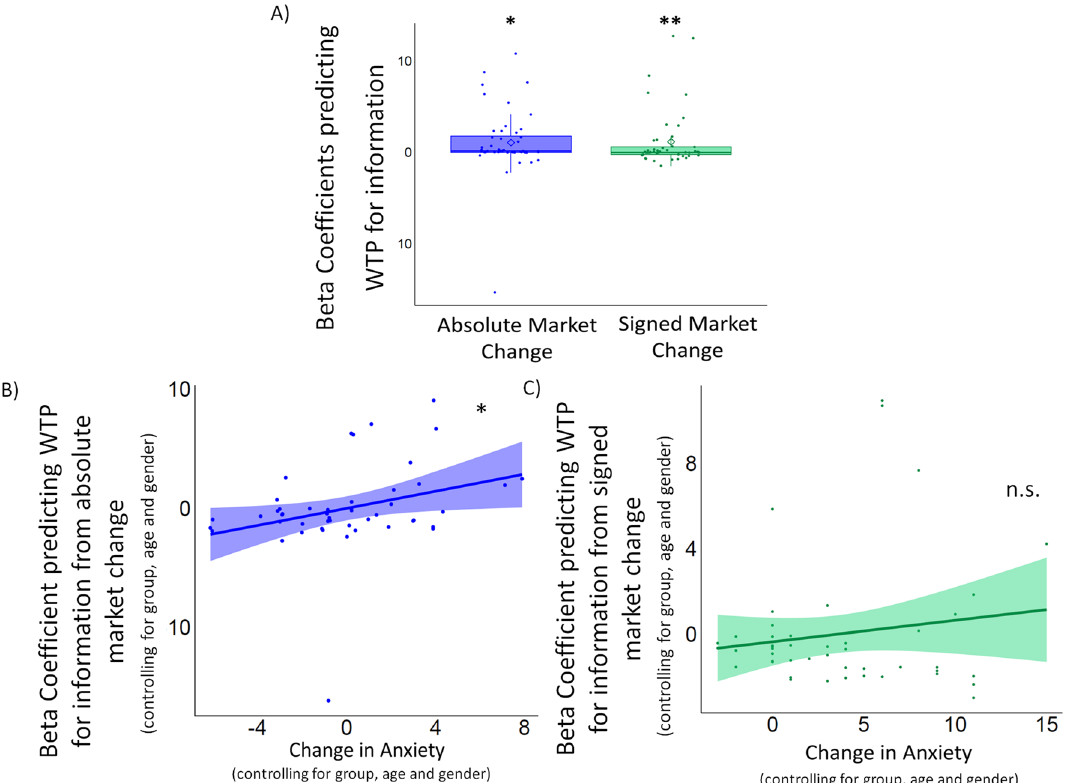
Figure 7. Induced anxiety led to greater information-seeking when the magnitude of changes in the environment increased, regardless of valence (Study 2b). ( A ) Both signed market change (signaling whether the market was going up or down) and absolute market change (signaling the magnitude of changes in the market) predicted participants’ willingness to pay for information. Plotted are the beta coefficients reflecting the effect of signed (green) and absolute (purple) market change on WTP. Horizontal lines indicate median values, boxes indicate 25–75% interquartile range, the crosses indicate mean values and whiskers indicate 1.5 × interquartile range; individual scores are shown separately as circles. ** p = 0.01, * p < 0.05. ( B ) Induced anxiety resulted in greater influence of magnitude of market change (p = 0.037; results do not change when excluding the one outlier). ( C ) Induced anxiety was not associated with the effect of valence of market change on information- seeking (p = 0.16). ( B , C ) Plotted are the partial linear regressions predicting the beta coefficients shown in ( A ) from change in anxiety, controlling for group, age and